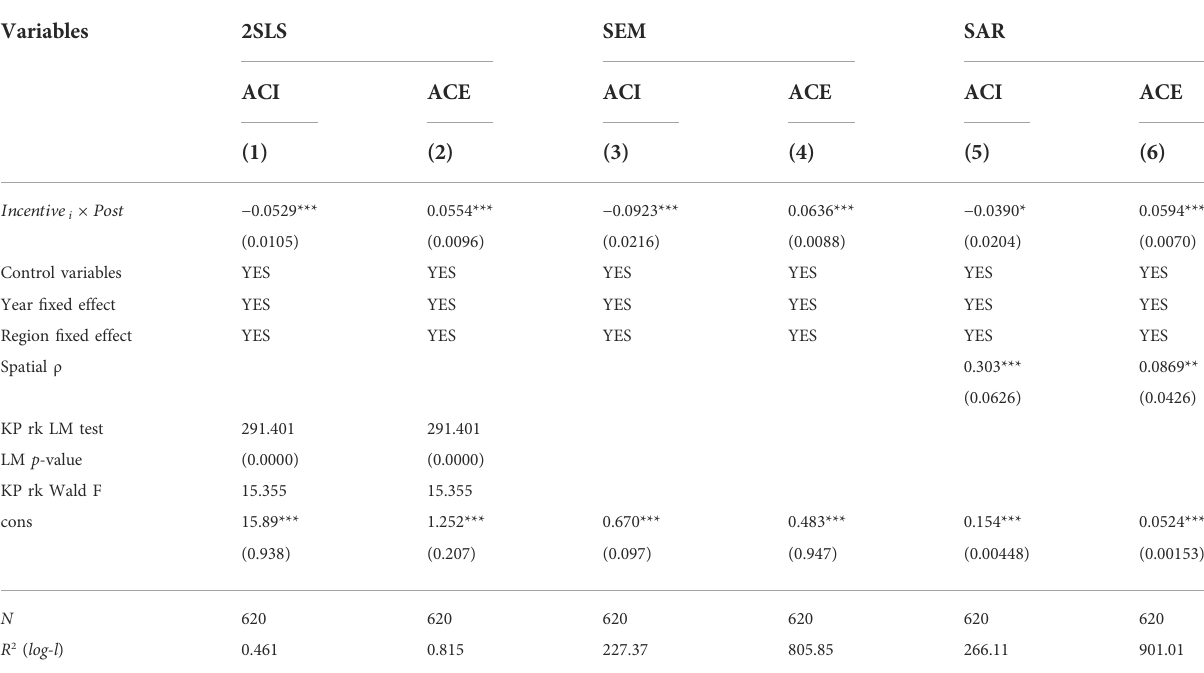
TABLE 3 Robustness tests